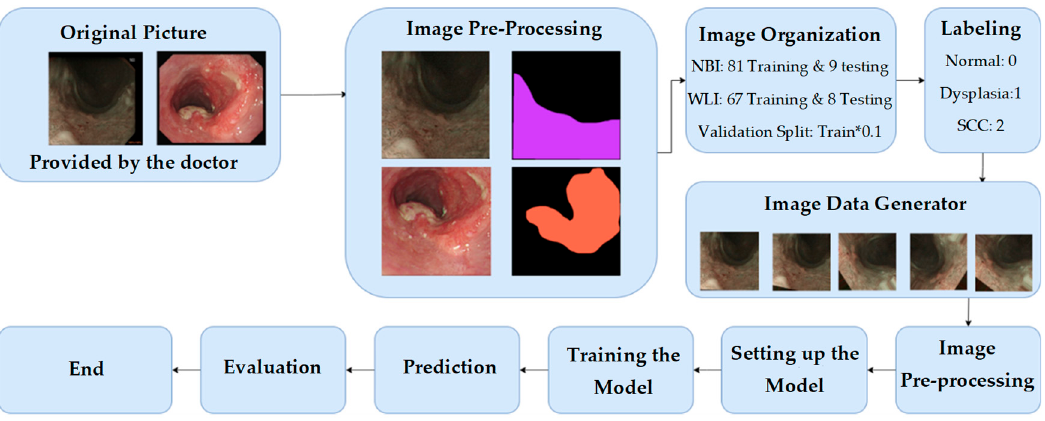
Figure 1. Overall experimental flow chart.